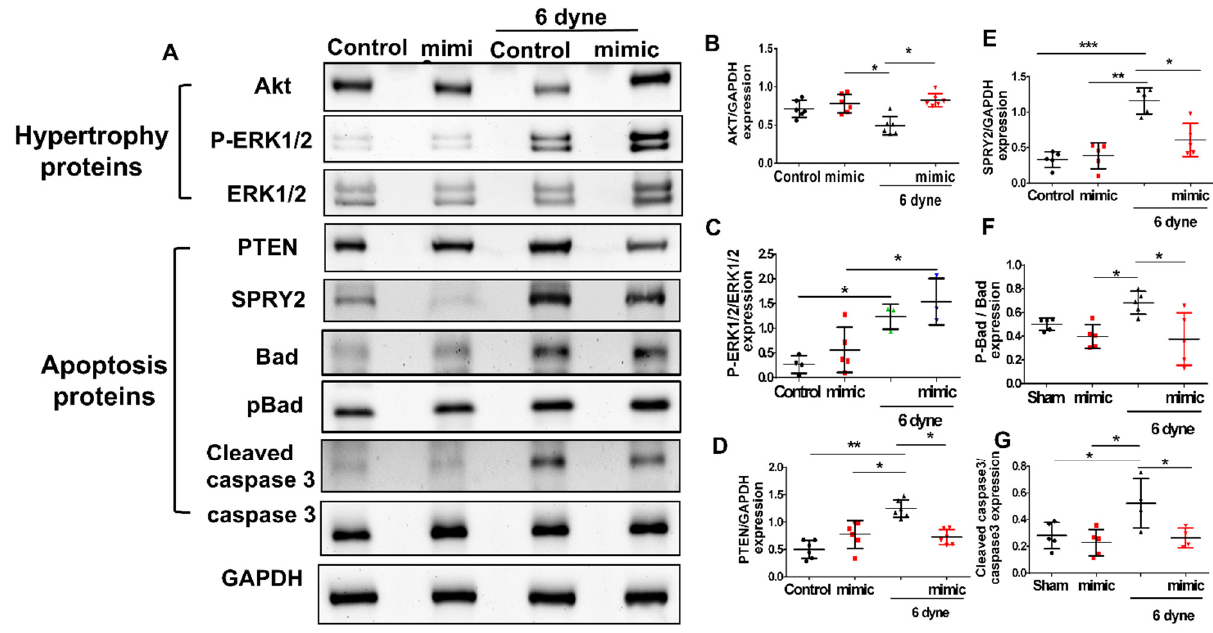
Figure 7. The over-expression of MiR-21 rescues the suppressed expressions of apoptosis-associated proteins in cardio- myocytes under flow-mediated shear stress. The cardiomyocytes were transfected with miR-21 mimic for 24 h. Western blot analysis of hypertrophy- ( A – C ) and apoptosis-associate proteins expression and ( D – G ) quantification of the results. Data are expressed using mean ± standard deviation (S.D.). * p < 0.05, ** p < 0.01, and *** p < 0.001 for difference between each group. (N =